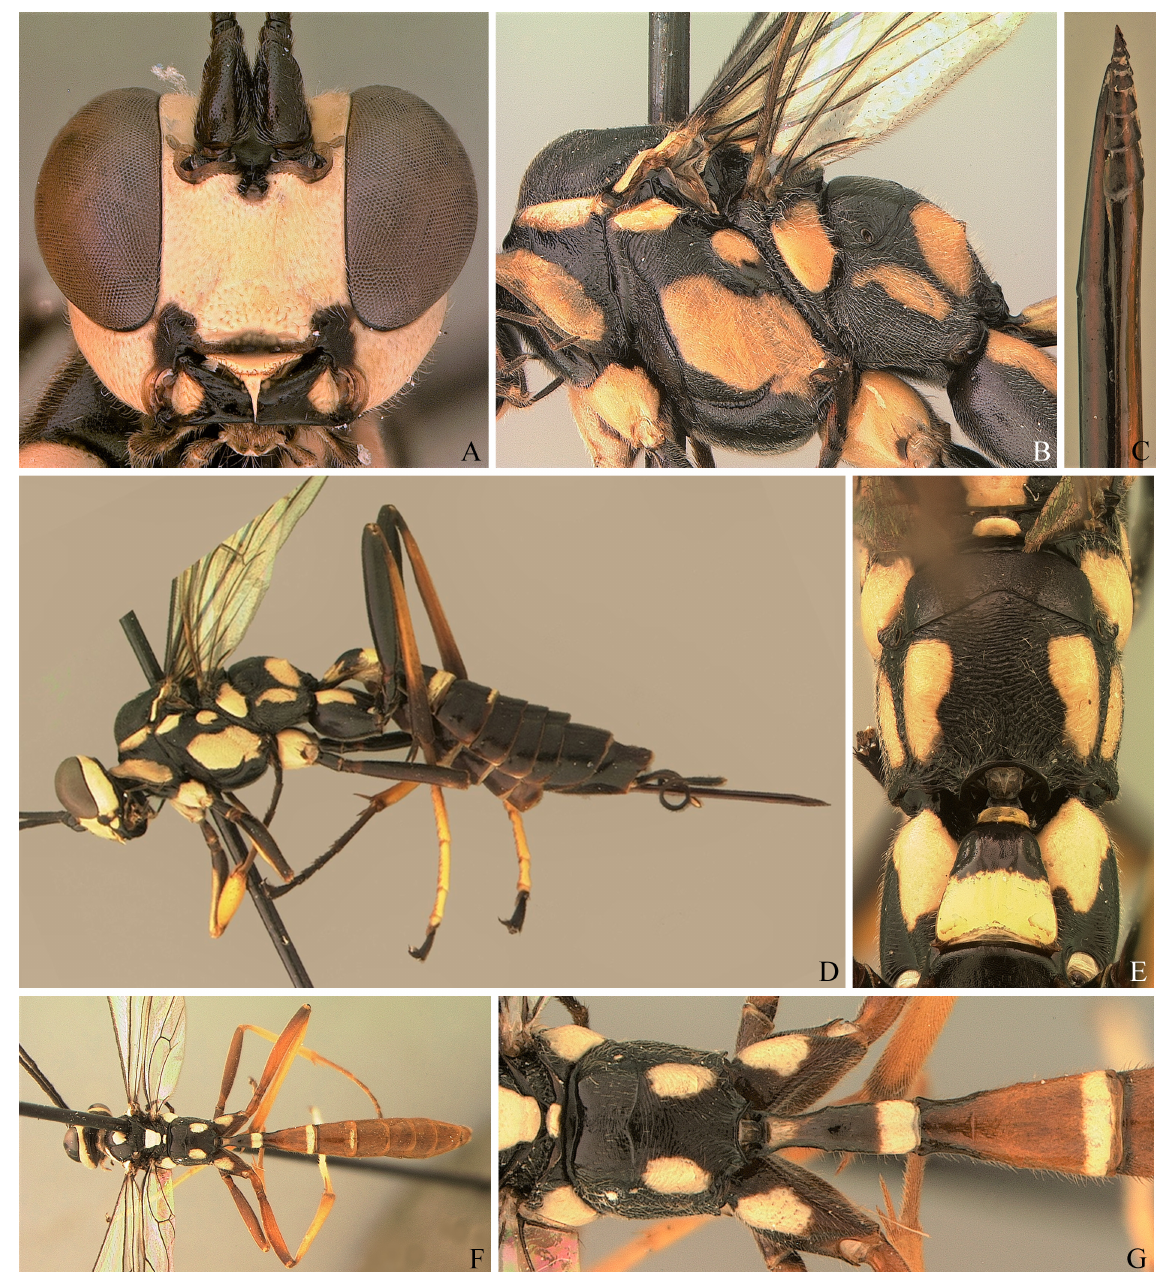
Fig. 10. Distictus daelus sp. nov. A–E . Holotype (USUC), ♀. A . Head, frontal view. B . Mesosoma, left side. C . Apex of ovipositor, left side. D . Habitus. E . Propodeum + hind coxae + first tergite, dorsal view. F . ♂, dorsal view. G . ♂, close-up of propodeum and basal